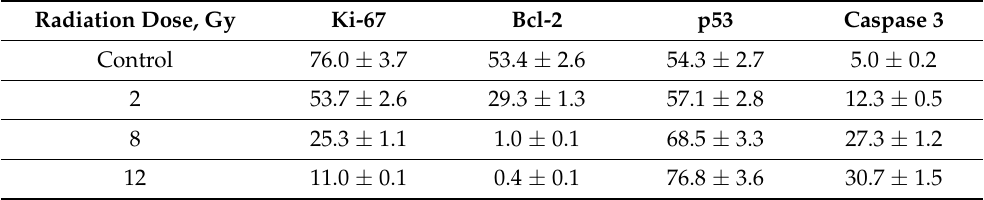
Table 1. Comparative characteristics of IHC-positive cells in seminiferous tubules after electron irradiation (%), p <